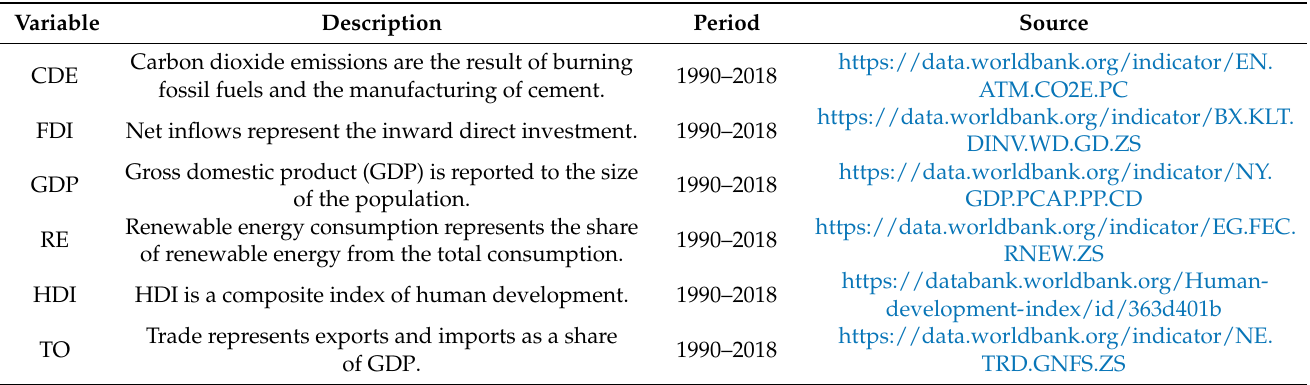
Table 1. Exhibition of the variables.